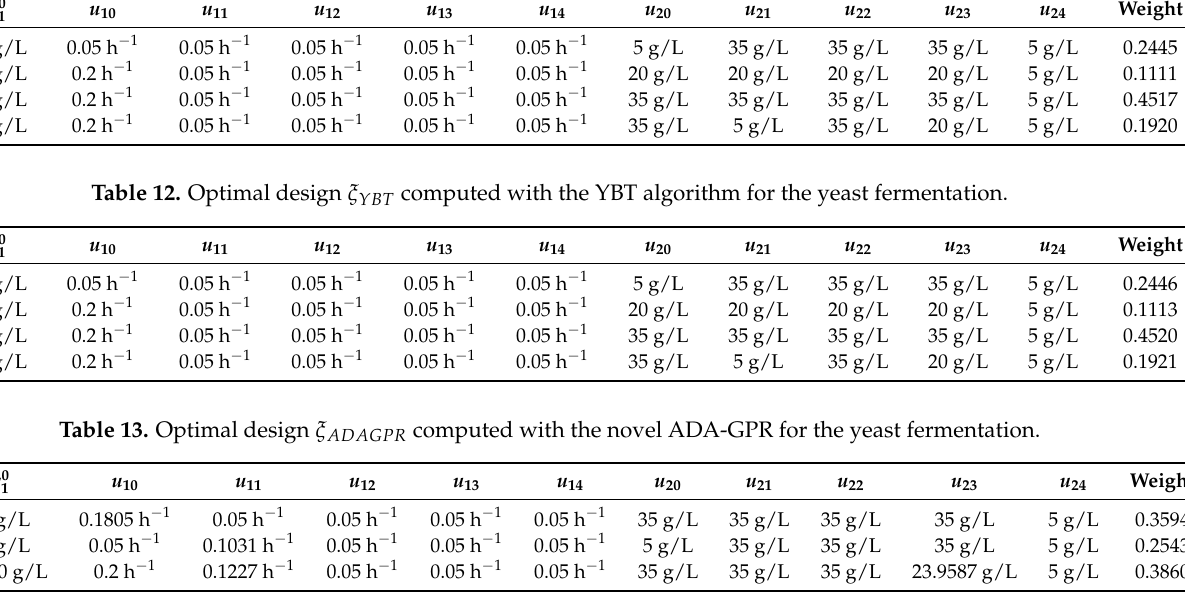
Table 14. Objective values, runtime and number of iterations of all three algorithms for the yeast fermentation.